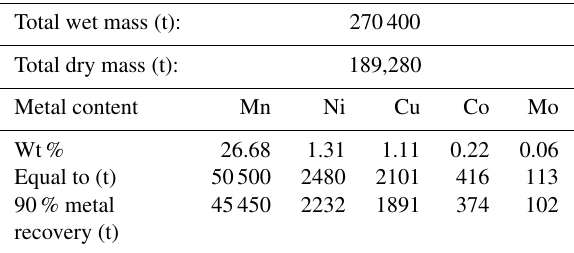
Table 6. The estimated amount of metal mass for five metals, based on the average values of metal content inside CCZ and a five-metal HCL-leach recovery method (Volkmann,